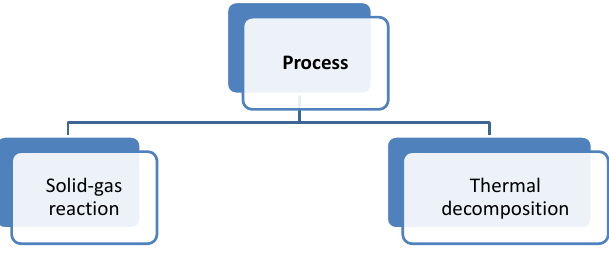
Figure 3. Classification according to the thermochemical material (TCM) process.